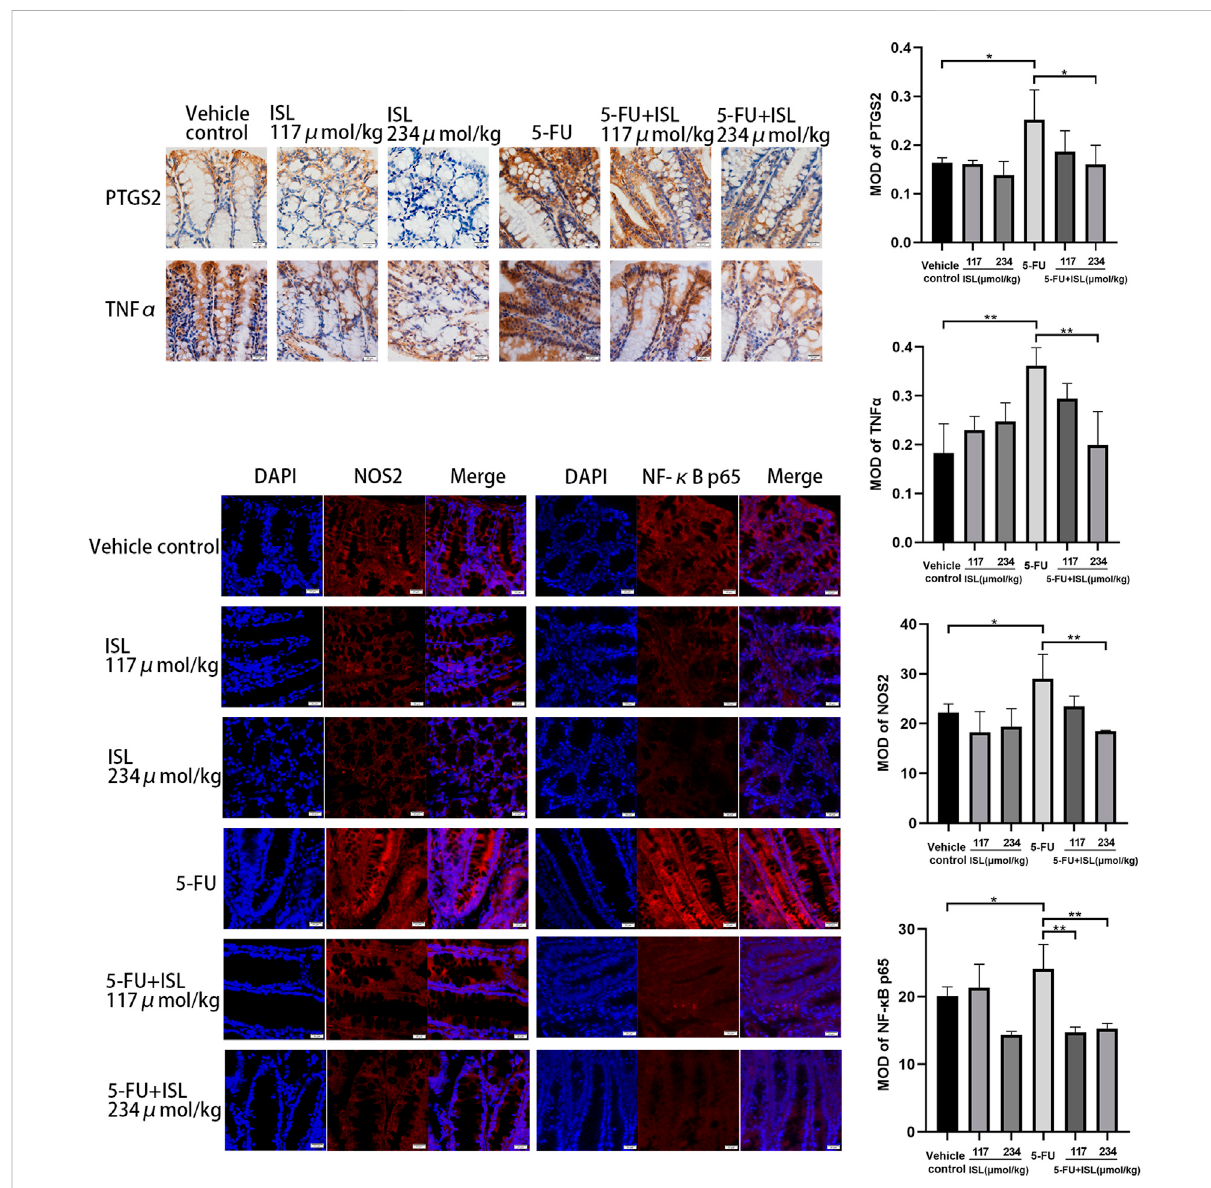
FIGURE 8 Immunohistochemistry and immuno fl uorescence analysis for PTGS2, NOS2, TNF α and NF- κ B p65. MOD, mean optical density. All images are displayed at ×400 magni fi cation. Data are presented as mean ± SD. (n = 3 in each group). * p < 0.05 and ** p <